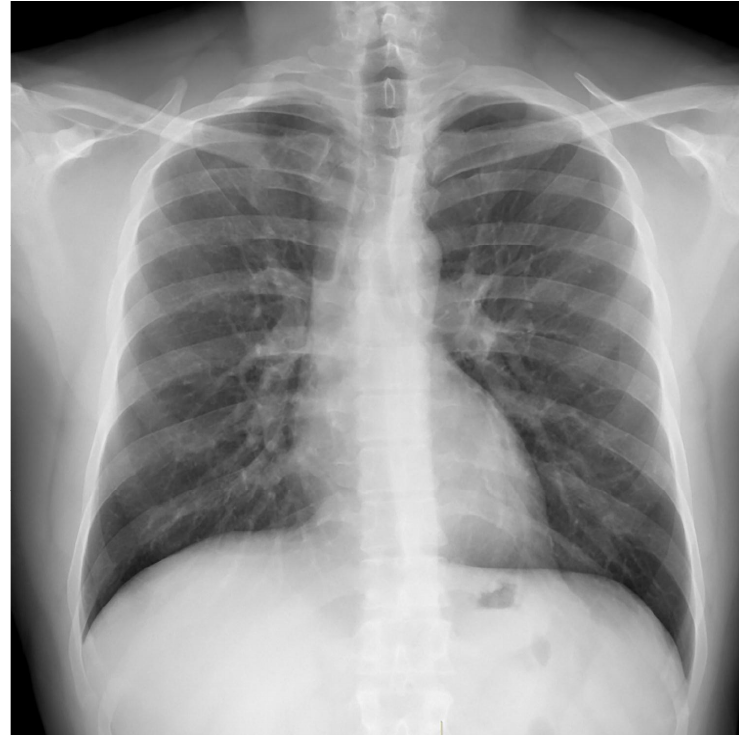
Figure 4. Case 7, 12th month of the